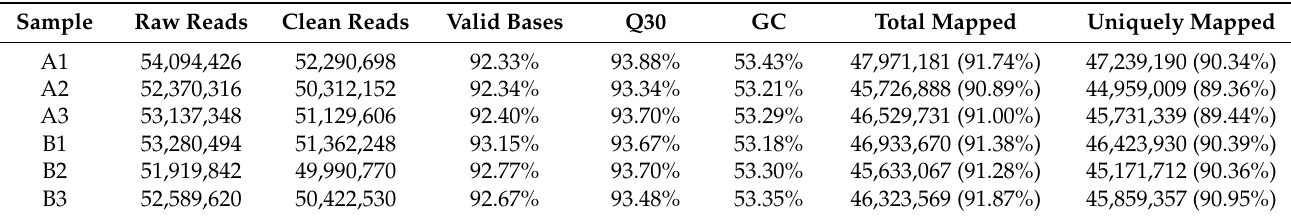
Table 3. Summary of the transcript expression levels.